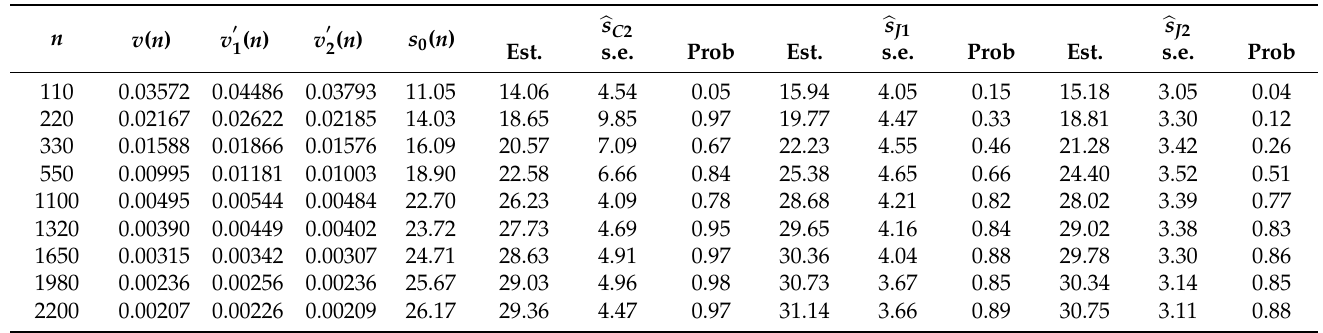
Table 4. Panama’s Crab Data (Numbers of species in two populations are s 1 = 55 & s 2 = 50 and the number of shared species is s 0 = 31; J 1 & J 2: 1st & 2nd Jackknife estimates, C 2: Chao’s estimate, s 0 ( n ): number of observed shared species).